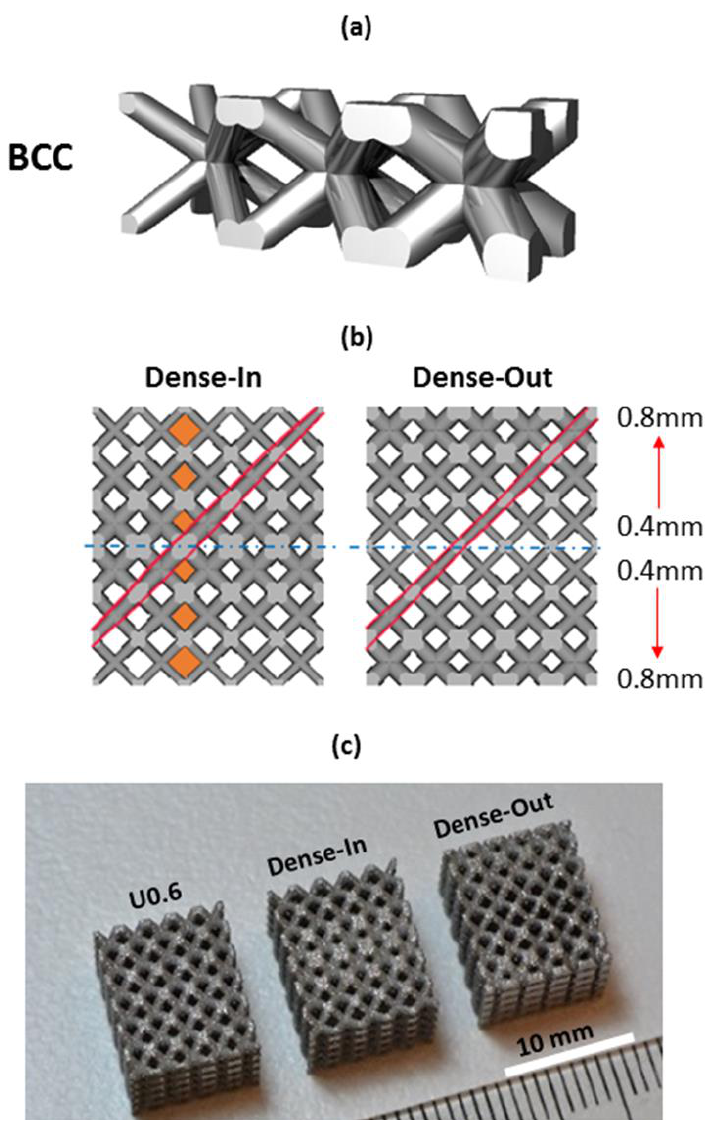
Figure 1. ( a ) Gradient BCC unit cell showing continuous transition at the unit cell junctions, ( b ) CAD view of the gradient BCC lattice scaffold; the arrows show the gradual increase in strut diameter and the highlighted areas show the gradually changing pore size and strut diameter along the scaffolds’ height; Dense-In scaffold has increasing strut diameter towards the center, whereas Dense-Out follows the opposite trend; ( c ) SLM-fabricated specimens with dimensions of 10 × 10 × 12 mm 3 , from left to right: uniform BCC lattice scaffold with 0.6 mm strut diameter, Dense-In and Dense-Out scaffolds.